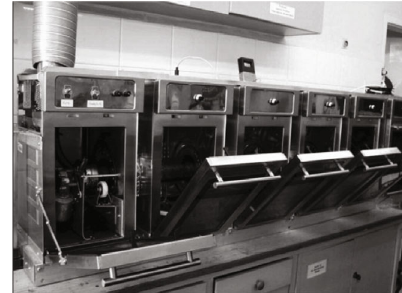
Figure 15: The Ertec continuous microwave reactor for the synthesis of high molecular weight epoxy resin (reprinted from Bogdal et al. [94] with permission. Copyright © 2022 American Chemical